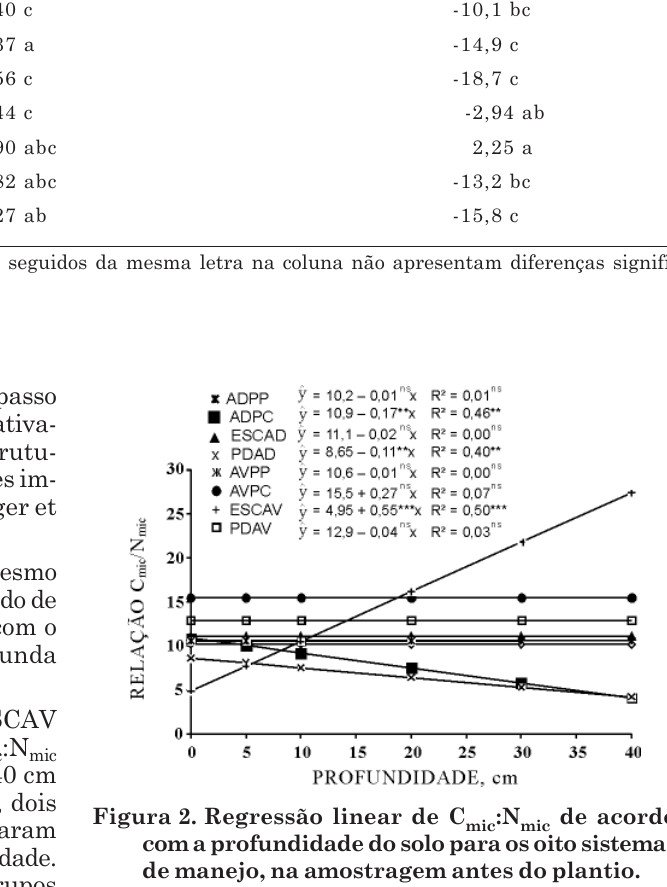
Figura 2. Regressão linear de C com a profundidade do solo para os oito sistemas de manejo, na amostragem antes do